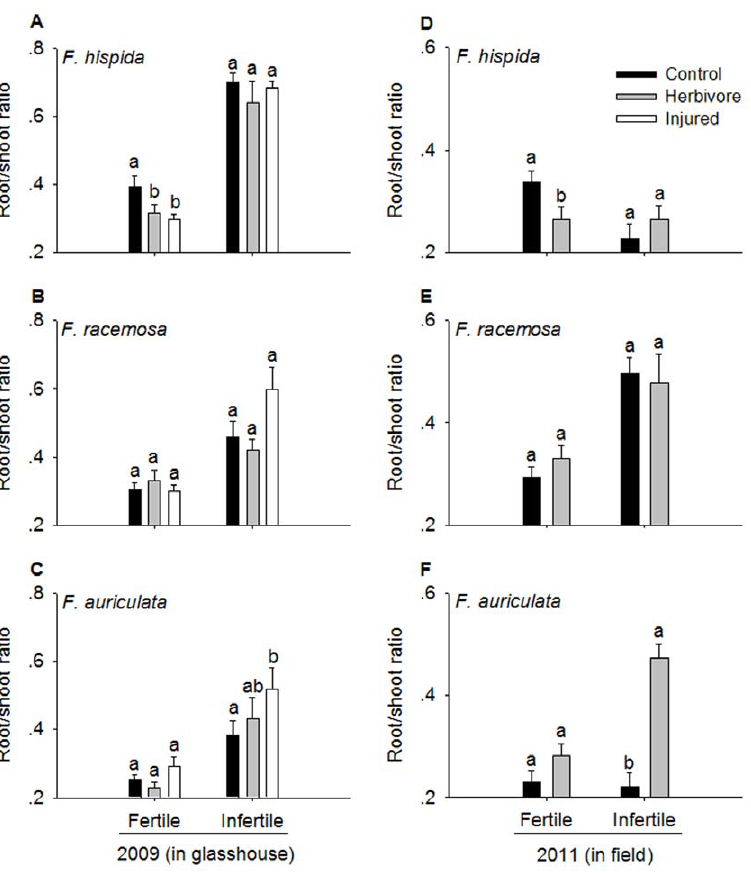
Figure 3. Effect of treatments on root/shoot ratio in Ficus saplings under two soil nutrient levels. Significant differences between treatments are marked with different letters (mean 6 SE, n=5 in 2009, n=12 in 2011, P , 0.05).